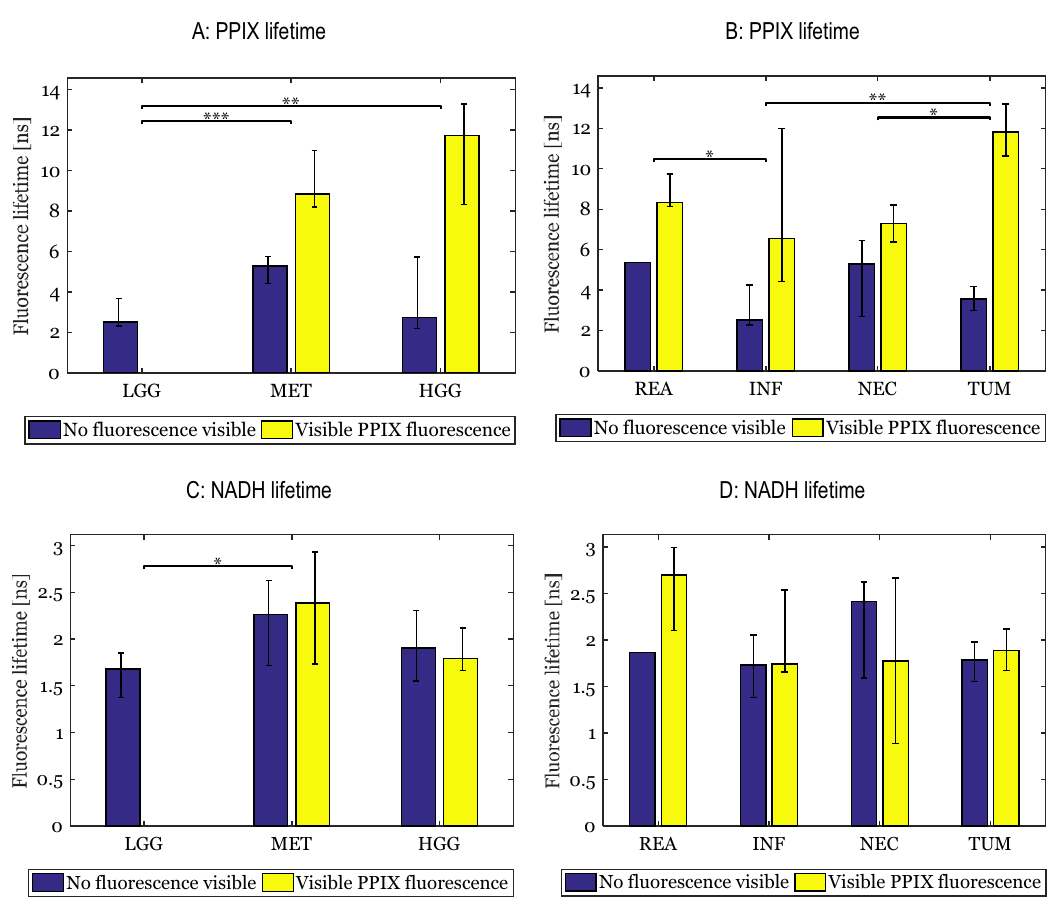
Figure 3. Fluorescence lifetime distribution depending on the tumor grade (PPIX: a ; NADH: c and the tissue type (PPIX: b ; NADH: d )—The bar height shows the median NADH/PPIX fluorescence lifetime while the error bars indicate the 25 and 75% quantiles. The PPIX fluorescence visibility was based on the surgeon’s subjective observation during resection (no visible fluorescence: ALA−; visible PPIX fluorescence: ALA+). Note that we did not include non-pathological samples due to the small sample size (n = 2) and there is no error indicated for reactive parenchyma with no visible fluorescence (ALA−) as we only found one sample with these characteristics. Significant differences between the groups are shown with an overline (*p < 0.05; **p < 0.01; ***p < 0.001) and are independent of the visual PPIX fluorescence status. Low grade gliomas showed significantly lower NADH and PPIX fluorescence lifetimes compared to brain metastases. On the other hand, metastases and high grade gliomas had fairly similar PPIX fluorescence lifetimes. Samples with visible PPIX fluorescence during surgery (ALA+) were associated with significantly elevated PPIX fluorescence lifetimes. Reactive tissue showed the highest NADH fluorescence lifetimes compared to all other tissue